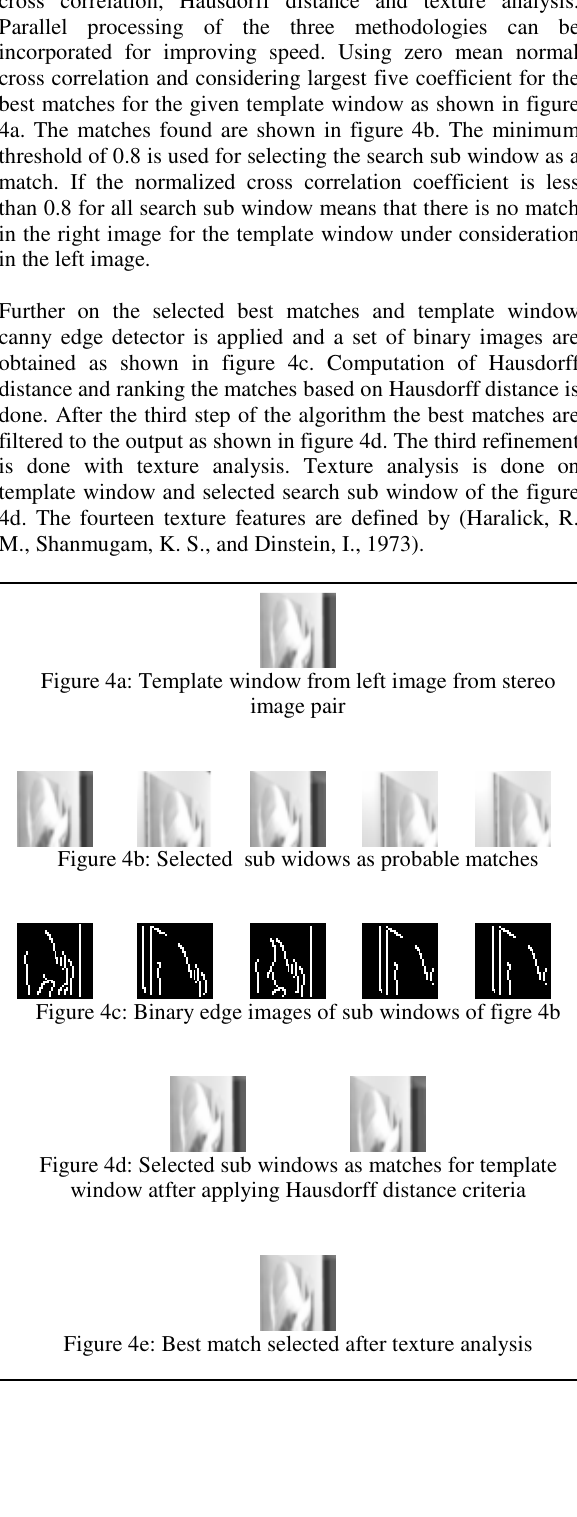
Figure 4e: Best match selected after texture